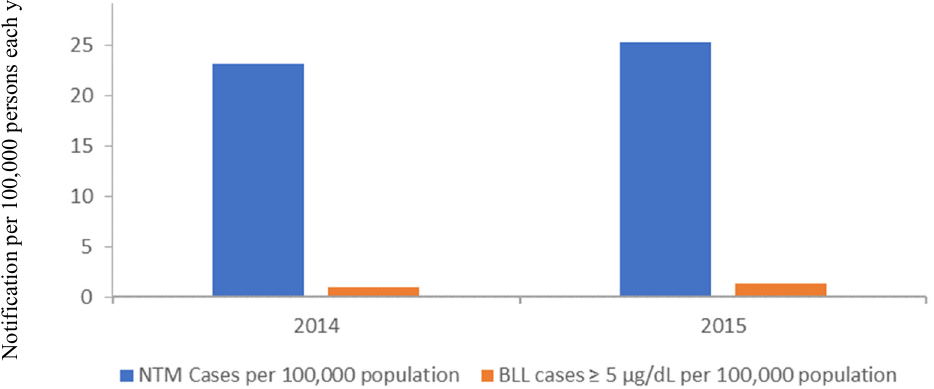
Figure 4. Rate of NTM Infections and blood lead levels (BLL) ≥ 5 µg/dL in Queensland for the years 2014 and 2015. Source: https://www.health.qld.gov.au.